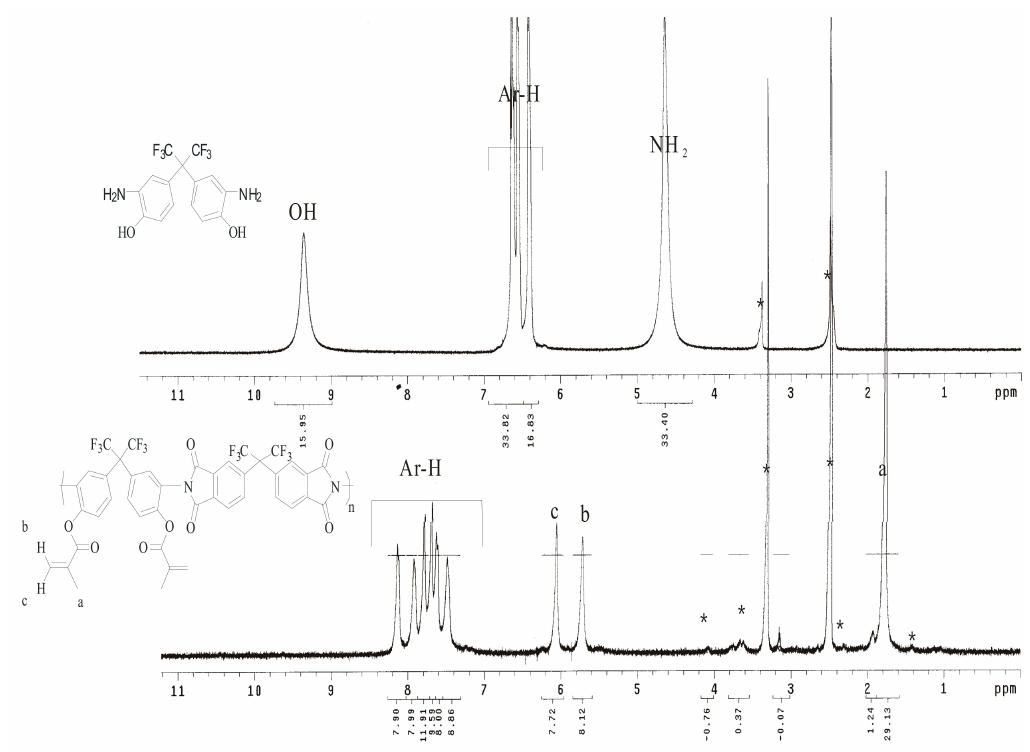
Figure 3. 1 H-NMR spectra of hydroxyl diamine (3) and P3–MMA in DMSO- d 6 . (*: